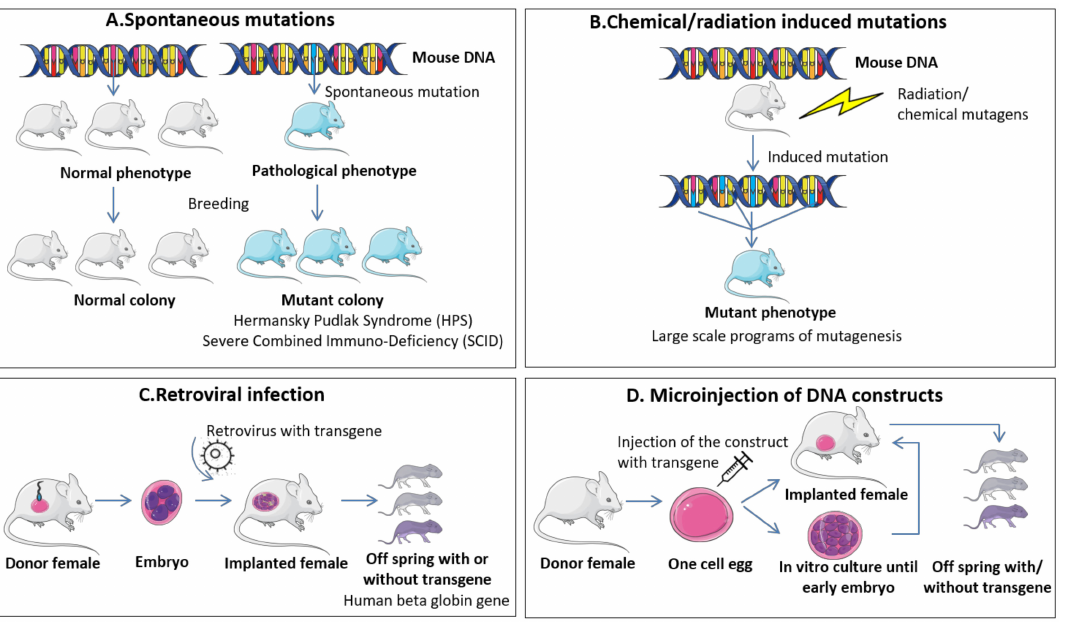
Figure 1. Widely used methods for generation of transgenic mice. ( A ) Spontaneous mutations. These types of modifications appear spontaneously in mice colonies after successive breeding events and are usually detected when associated with a phenotypic change. The analysis of the genetic background of spontaneously mutated mice can be associated with events encountered in human pathologies and further used as models of specific diseases. ( B ) Chemical / radiation induced mutations. These genetic modifications are based on the exposure of mice to mutagens like ethylnitrosourea (ENU) that can be used for large scale programs of mutagenesis and establishment of specific genetic alteration patterns responsible for human diseases. ( C ) Retroviral infection. This method is one of the first partially controlled protocols for generation of transgenic mice and is based on the transfection of preimplantation embryos with a retrovirus that contains the gene to be replaced / modified. The modified embryos are implanted into recipient females and analyzed for the presence or absence of the genetic modifications in concordance with the developed phenotype. ( D ) Microinjection of DNA constructs. The protocol, as the name suggests, comprises the direct injection of DNA constructs into one-cell fertilized embryos followed by transfer in recipient females and analysis of the presence or absence of the genetic modifications in concordance with the developed